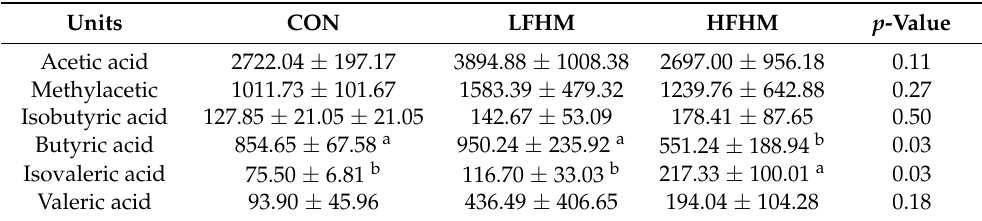
Table 6. Effects of different amounts of fermented Chinese herbal medicine on the content of SCFASs in intestinal tract of weaned piglets ( µ